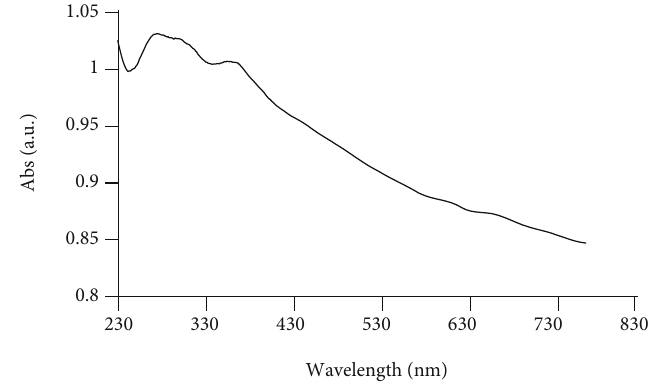
Figure 1: UV-visible spectrum of as prepared GFT.